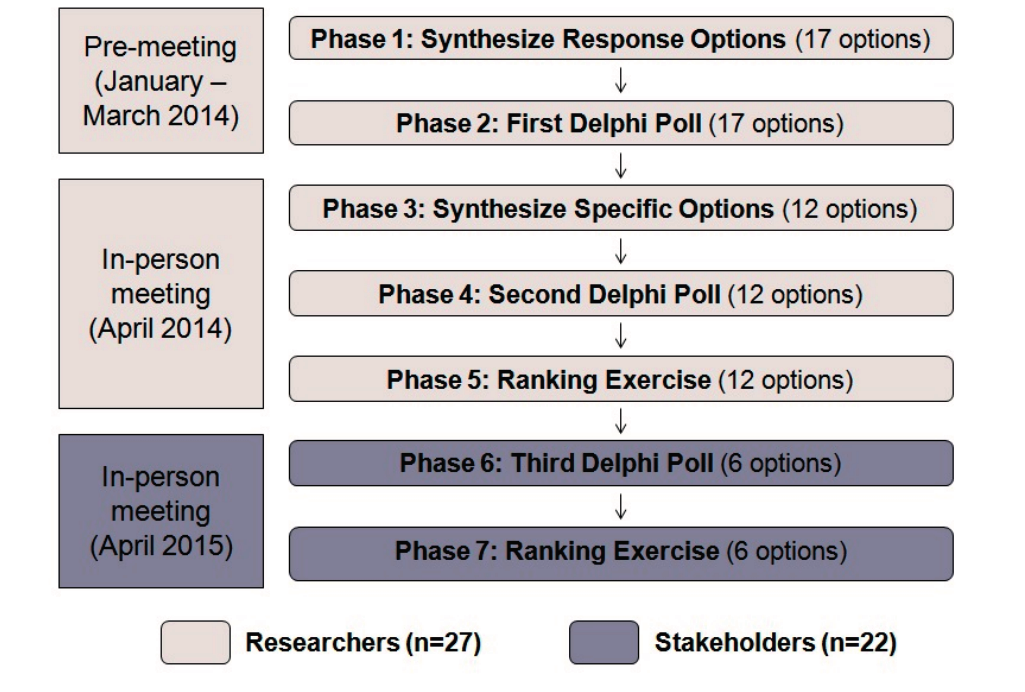
Figure 1. A flowchart of the Delphi